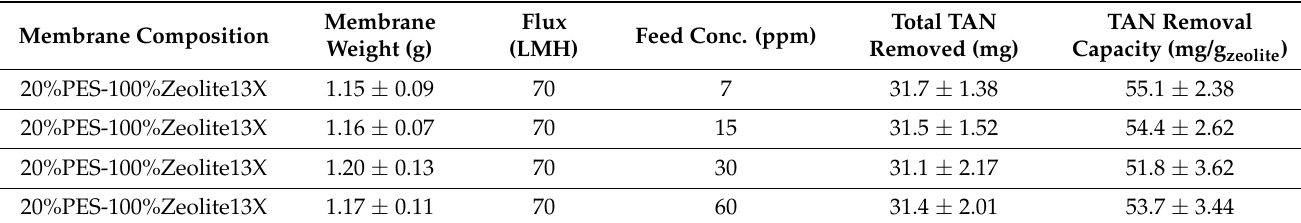
Figure 5. The effects of TAN concentration in the feed on its removal rate at LMH 70 for the fabricated membranes with the same composition. Table 2. TAN removal capacities of fabricated mixed-matrix membranes with the composition of 20%PES-100%Zeolite13X at feed concentrations of 7, 15, 30, and 60 ppm,